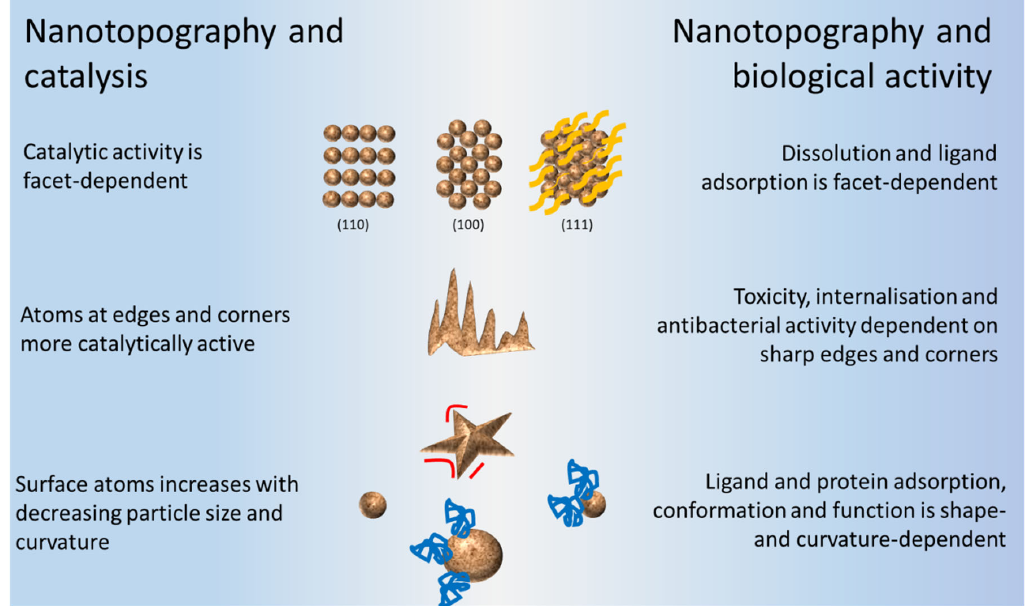
Figure 7. The role of nanotopography in both the catalytic and biological activities of NMs.